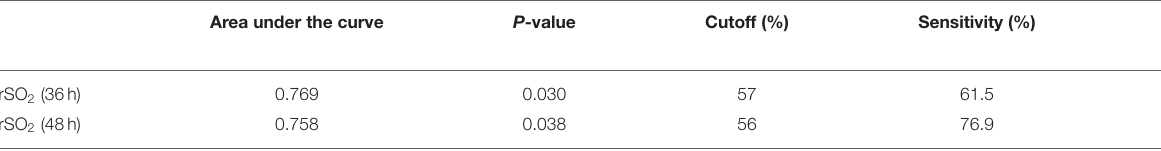
TABLE 5 | Cut-off of CrSO 2 for the prediction of mortality.